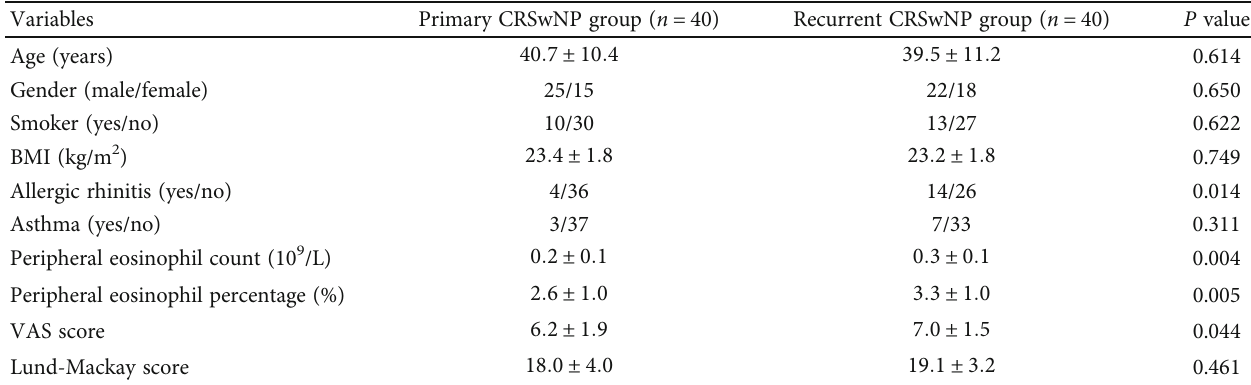
Table 2: The demographic and clinical parameters between primary and recurrent CRSwNP group.